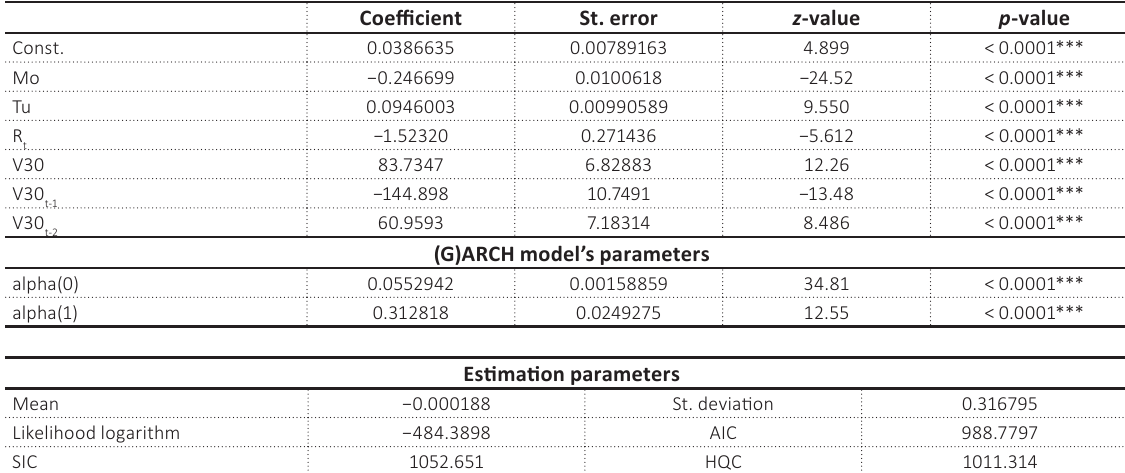
Table 1. ARCH(1) estimation for DAX index Coefficient St. error z -value p